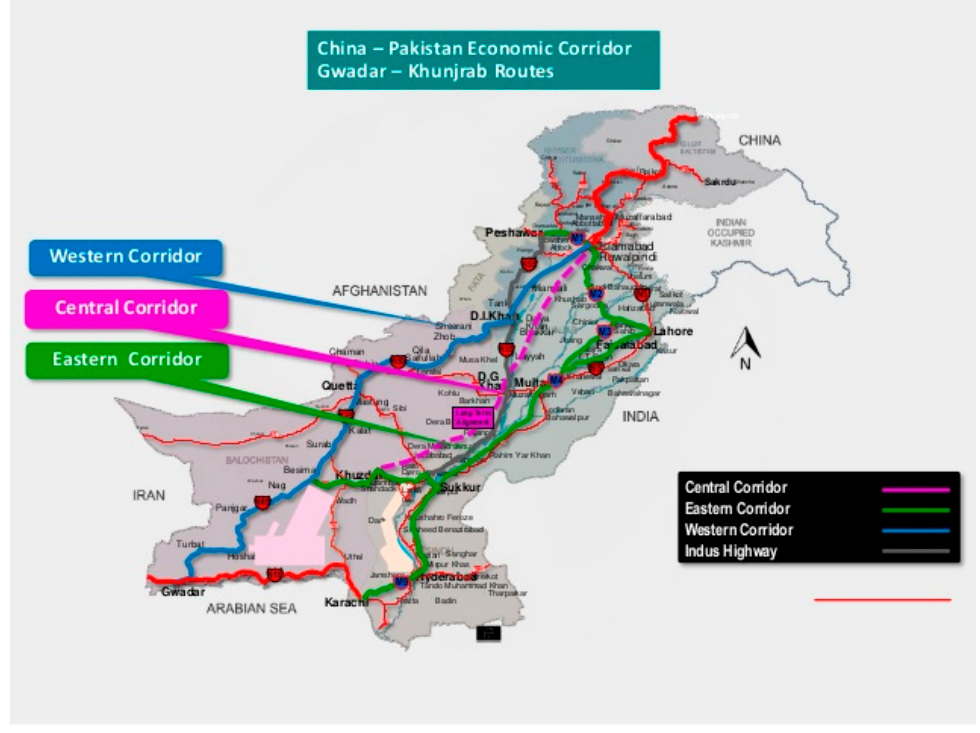
Figure 1. The framework of the three corridors.